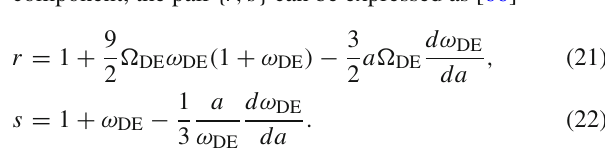
Fig. 5 a (Left panel) Variations of the present value (at z = 0 or a = 1) of the dark energy equation of state parameters ω 0 for quintessence dark energy model (solid lines) and Slotheon field dark energy model (dashed lines). Effects of absence and presence of the